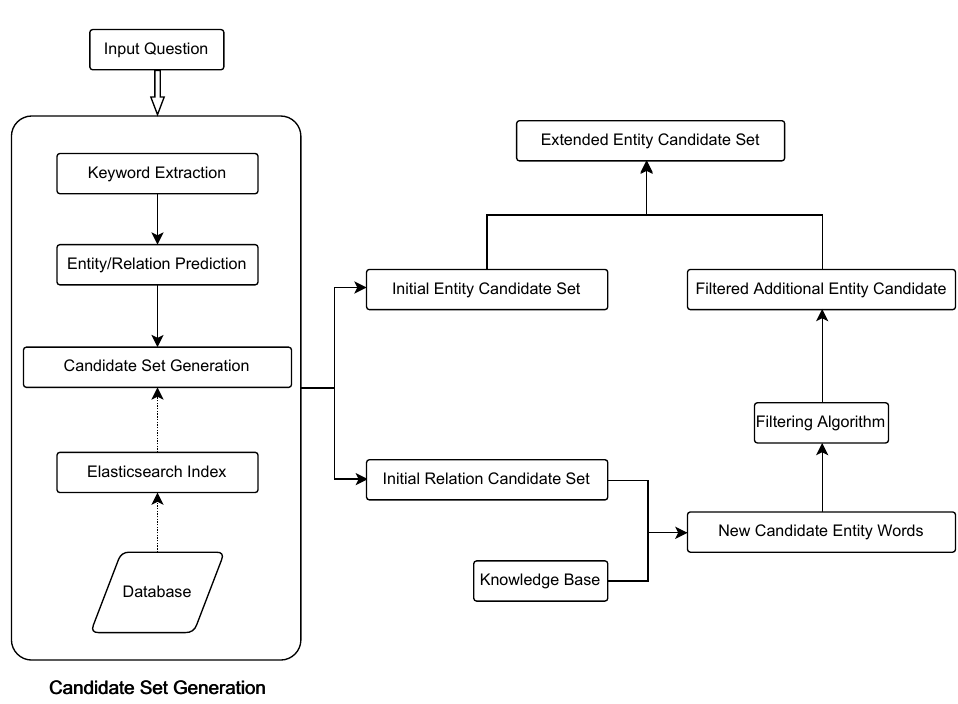
Figure 4. Framework of entity candidate set expansion algorithm.